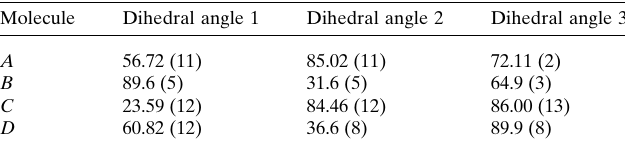
Table 2 Selected dihedral angles ( (cid:2) ). Dihedral angle 1 is the dihedral angle between the mean planes of the 4- methoxyphenyl rings; dihedral angle 2 is the dihedral angle between the mean planes of the benzyl (C20–C25) and 4-methoxyphenyl (C1–C6) rings; dihedral angle 3 is the dihedral angle between the mean planes of the benzyl (C20–C25) and the 4-methoxyphenyl (C12–C17) rings.